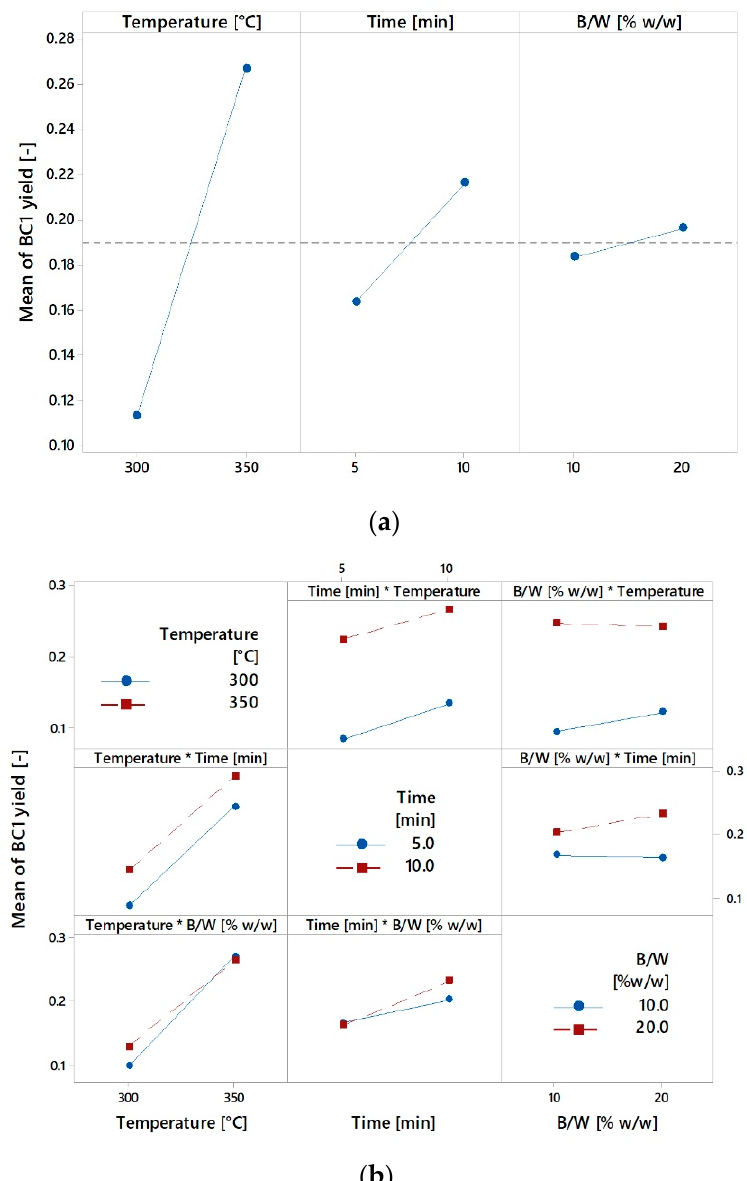
Figure A1. Influence of operating parameters on the yield of biocrude 1: main effects plot ( a ) and interaction effects plot ( b ).